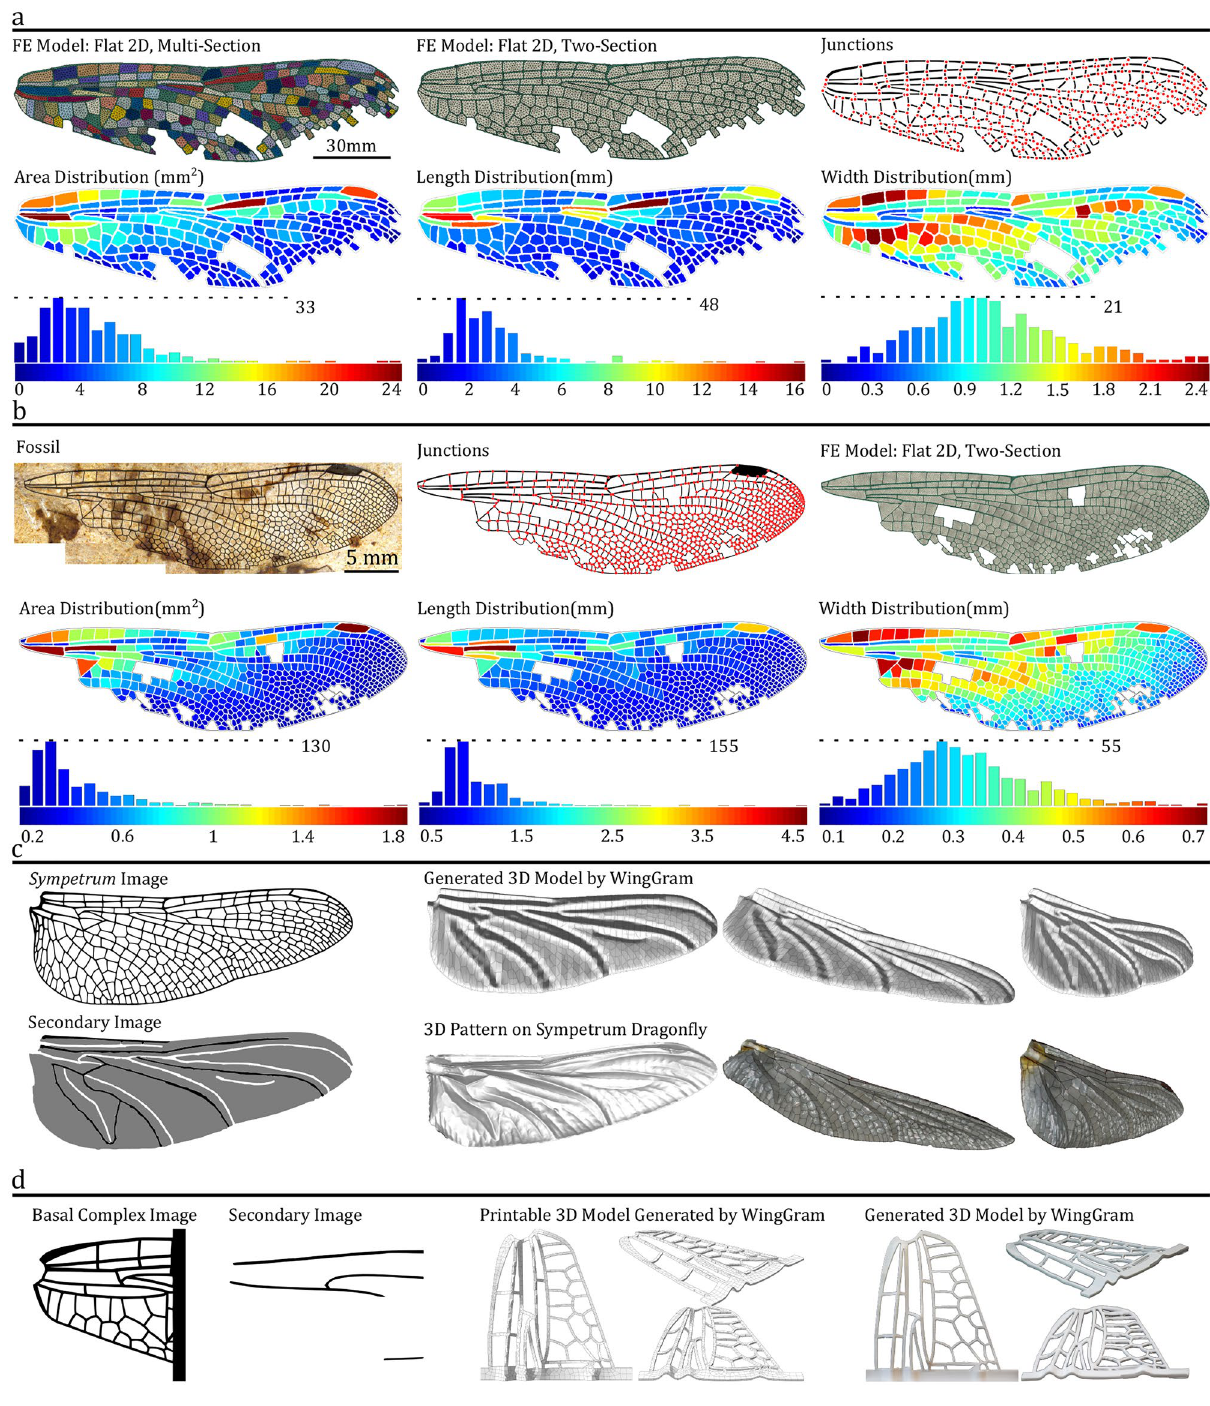
Figure 5. The application of WingGram in modelling damaged wings, fossil wings and corrugated wing corrugations, and its use in 3D printing. ( a ) Damaged wing of dragonfly 47 : main image; secondary image to assign corrugation; Flat 2D, two-section FE model; Flat 2D multi-section FE model; corrugated 3D model; location of vein junctions; area, length, and width distribution contour and histogram. ( b ) The fossil wing: photograph of Auroradraco eos 46 ; location of vein junctions; Flat 2D, two-section FE model; area, length, and width distribution contour and histogram. ( c ) Comparison of the corrugations of a dragonfly wing ( Sympetrum vulgatum ) obtained by a 3D measurement microscope Keyence VR 3100 and WingGram : the image of a Sympetrum dragonfly; secondary image for assigning corrugations; the 3D model generated by WingGram ; 3D scan by Keyence VR 3100. ( d ) The 3D printable model generated by WingGram : dragonfly basal complex image; secondary image to assign corrugation; the virtual model of the basal complex; the virtual corrugated model developed by WingGram; 3D printed model of the basal